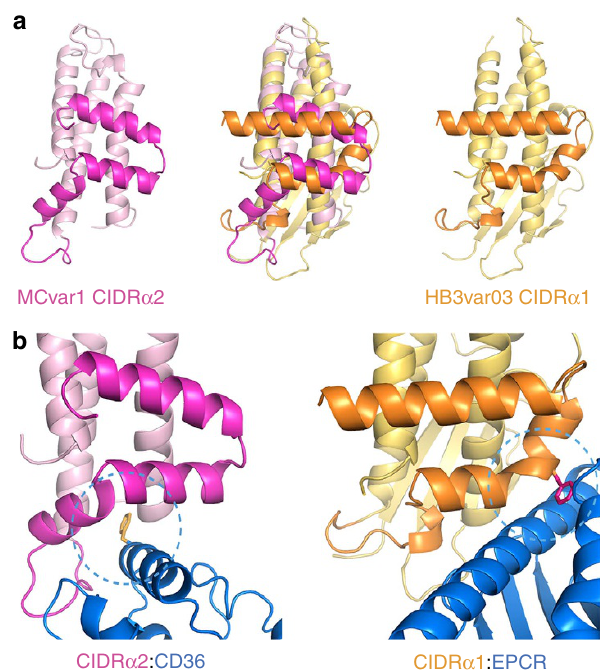
Figure 3 | A comparison of the features that allow CIDR a domains to bind to EPCR or CD36. ( a ) A comparison of the structure of a CD36- binding CIDR a 2 domain (pink) with that of an EPCR-binding CIDR a 1 domain (orange). Both domains share a core three a -helical bundle. The insertion that emerges between the second and third of these core helices forms a docking platform for ligands. ( b ) A close up of the binding interfaces that mediates the CIDR a 2:CD36 and CIDR a 1:EPCR interactions. The CIDR a 1 domains have a phenylalanine residue (F656) on a convex surface of the domain that protrudes into the hydrophobic groove of EPCR. In contrast, the CIDR a 2 domains have a hydrophobic pocket that binds to a protruding phenyalanine residue (F153) from